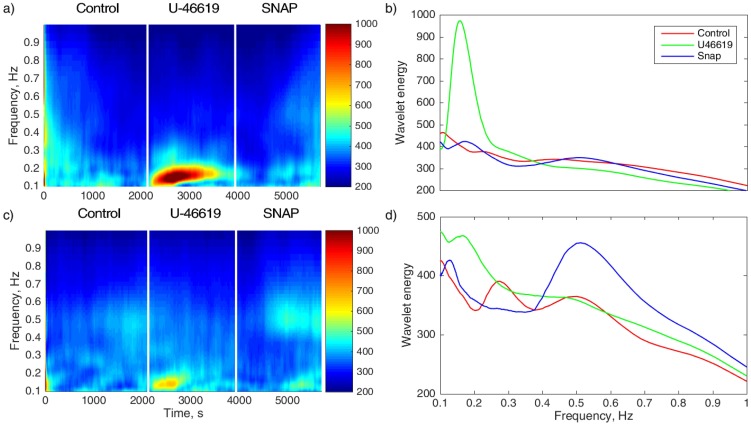
Wavelet analysis of SV recordings.Response of two vessels in the same representative rat. Left panels: Color-coded wavelet energy over frequencies and time. Right panels: Wavelet energy spectra where different colors correspond to control (red), U-46619 administration (green) and SNAP administration (blue) periods. Note that vessels in the same network may respond differently: (a,b) One vessel demonstrates vasomotion activity at the frequency of about 0.17 Hz in response to infusion of U-46619 and no Mayer wave activity is observed. (c,d) The other vessel demonstrates a weaker response to U-46619 at about 0.15 Hz but shows Mayer wave activity at 0.5 Hz in response to SNAP administration.